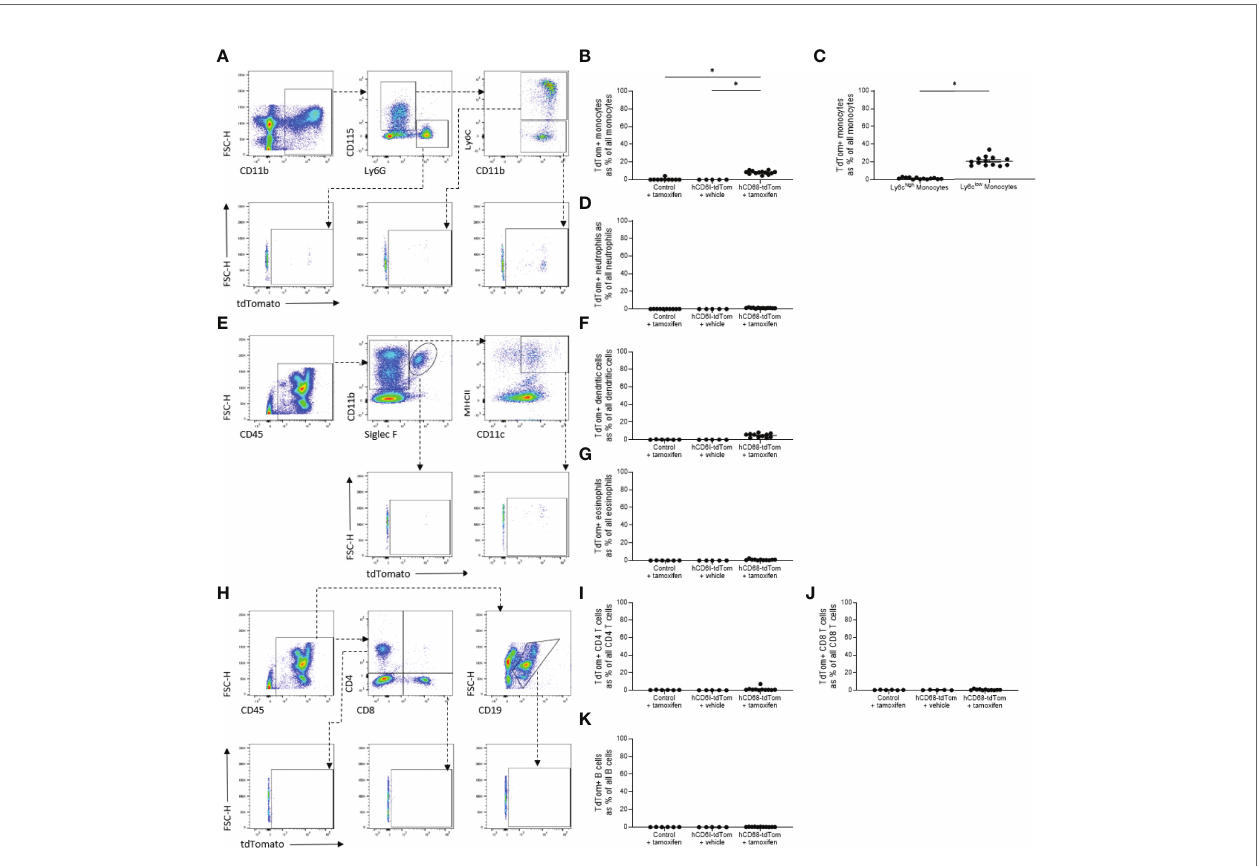
FIGURE 3 | The hCD68 promoter driven inducible Cre recombinase has limited activity in circulating leukocytes. (A) Representative dot plots of the gating strategy for neutrophils (CD11b + , CD115 - , Ly6G + ), total monocytes (CD11b + , CD115 + , Ly6G - ), Ly6C high and Ly6C low monocytes (CD11b + , CD115 + , Ly6G - , Ly6C + and CD11b + , CD115 + , Ly6G - , Ly6C - respectively). B) Frequency of tdTomato-expressing monocytes as a proportion of all monocytes. (C) Frequency of tdTomato- expressing Ly6C high and Ly6C low monocytes. (D) Frequency of tdTomato-expressing neutrophils as a proportion of all neutrophils. (E) Representative dot plots of the gating strategy for dendritic cells (CD45 + , CD11b + , Siglec F - , MHCII + , CD11c + ) and eosinophils (CD45 + , CD11b + , Siglec F + ). (F) Frequency of tdTomato-expressing dendritic cells as a proportion of all dendritic cells. (G) Frequency of tdTomato-expressing eosinophils as a proportion of all eosinophils. (H) Representative dot plots of the gating strategy for CD4 T cells (CD45 + , CD4 + , CD8 - ), CD8 T cells (CD45 + , CD4 - , CD8 + ) and B cells (CD45 + , CD19 + ). (I) Frequency of tdTomato-expressing CD4 T cells as a proportion of all CD4 T cells. (J) Frequency of tdTomato-expressing CD8 T cells as a proportion of all CD8 T cells. (K) Frequency of tdTomato- expressing B cells as a proportion of all B cells; one-way ANOVA or student t-test as appropriate, (* = p <